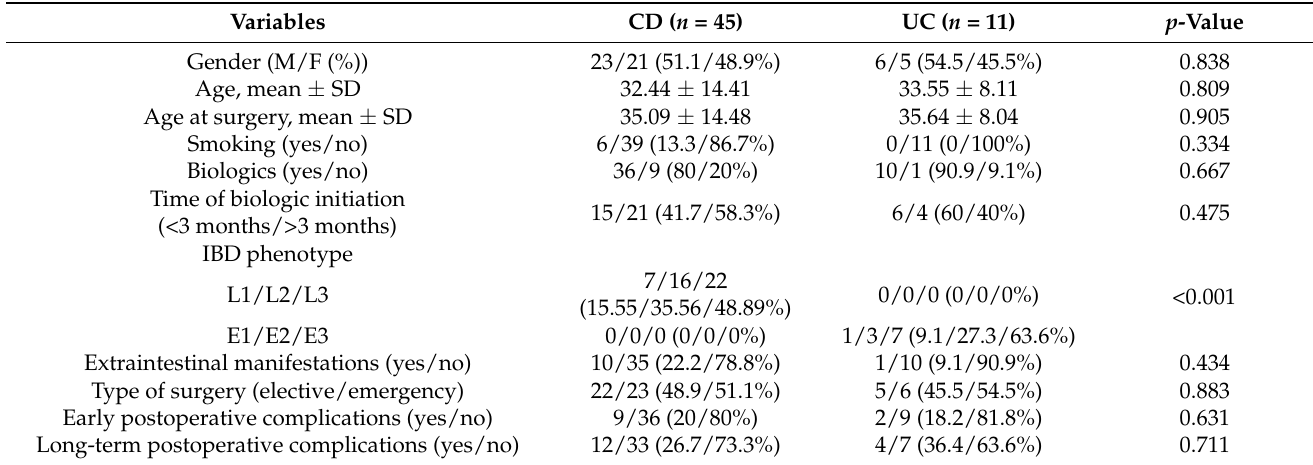
Table 2. Comparison of CD and UC